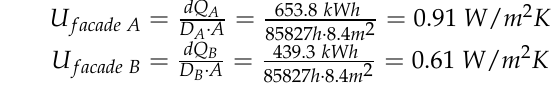
Table 5. Thermal transmittance through the test walls, based on material properties and based on energy use data.